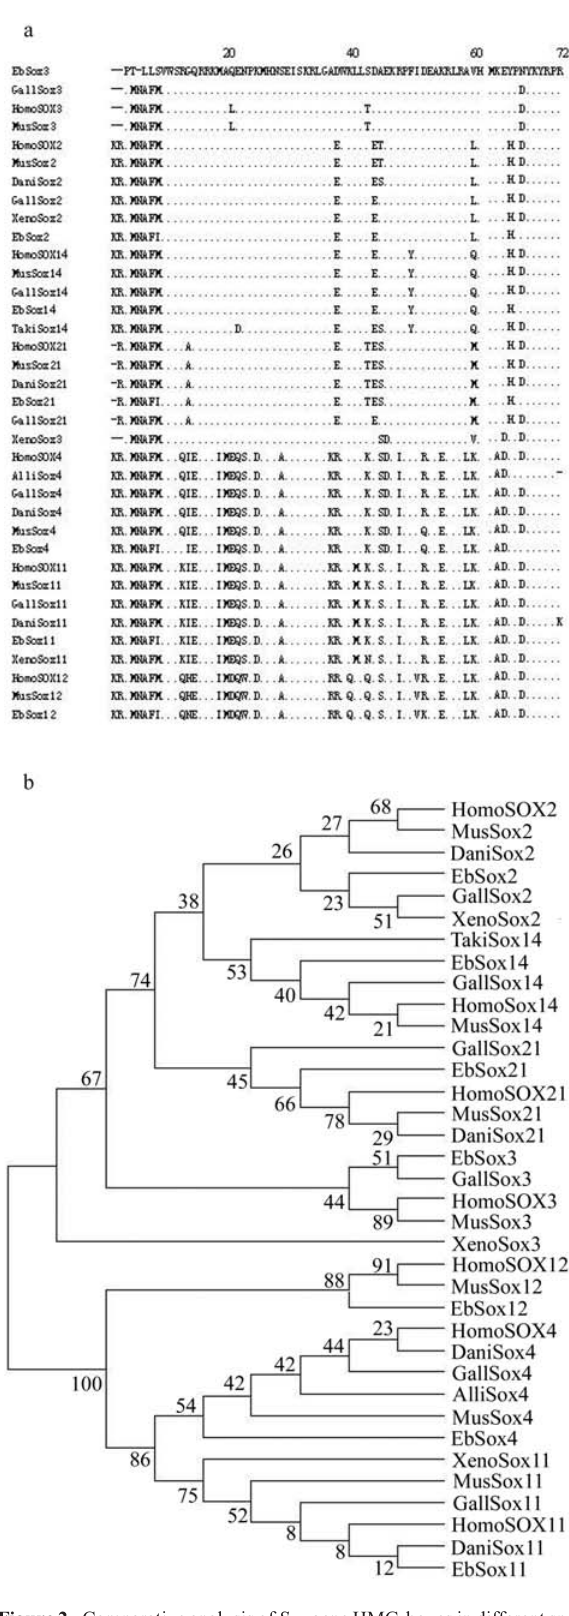
Figure 2 - Comparative analysis of Sox gene HMG-boxes in different spe- cies. (a) multiple alignment results; dots indicate identities with EbSox3 ; (b) phylogenetic analysis of the Sox gene